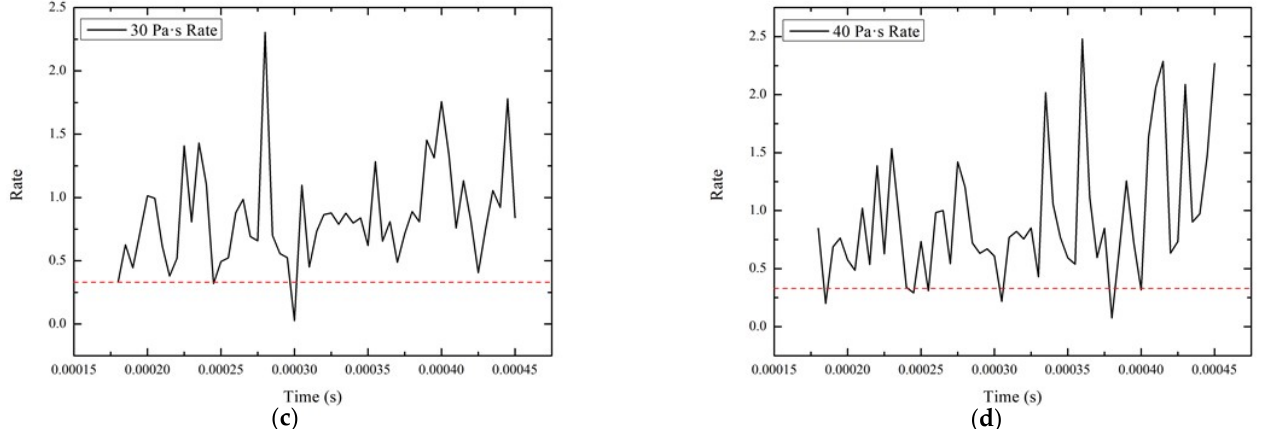
Figure 10. Force ratio of the tangential force to the normal force under different viscosities ( a ) 10 Pa · s viscosity, ( b ) 20 Pa · s viscosity, ( c ) 30 Pa · s viscosity, ( d ) 40 Pa · s viscosity.